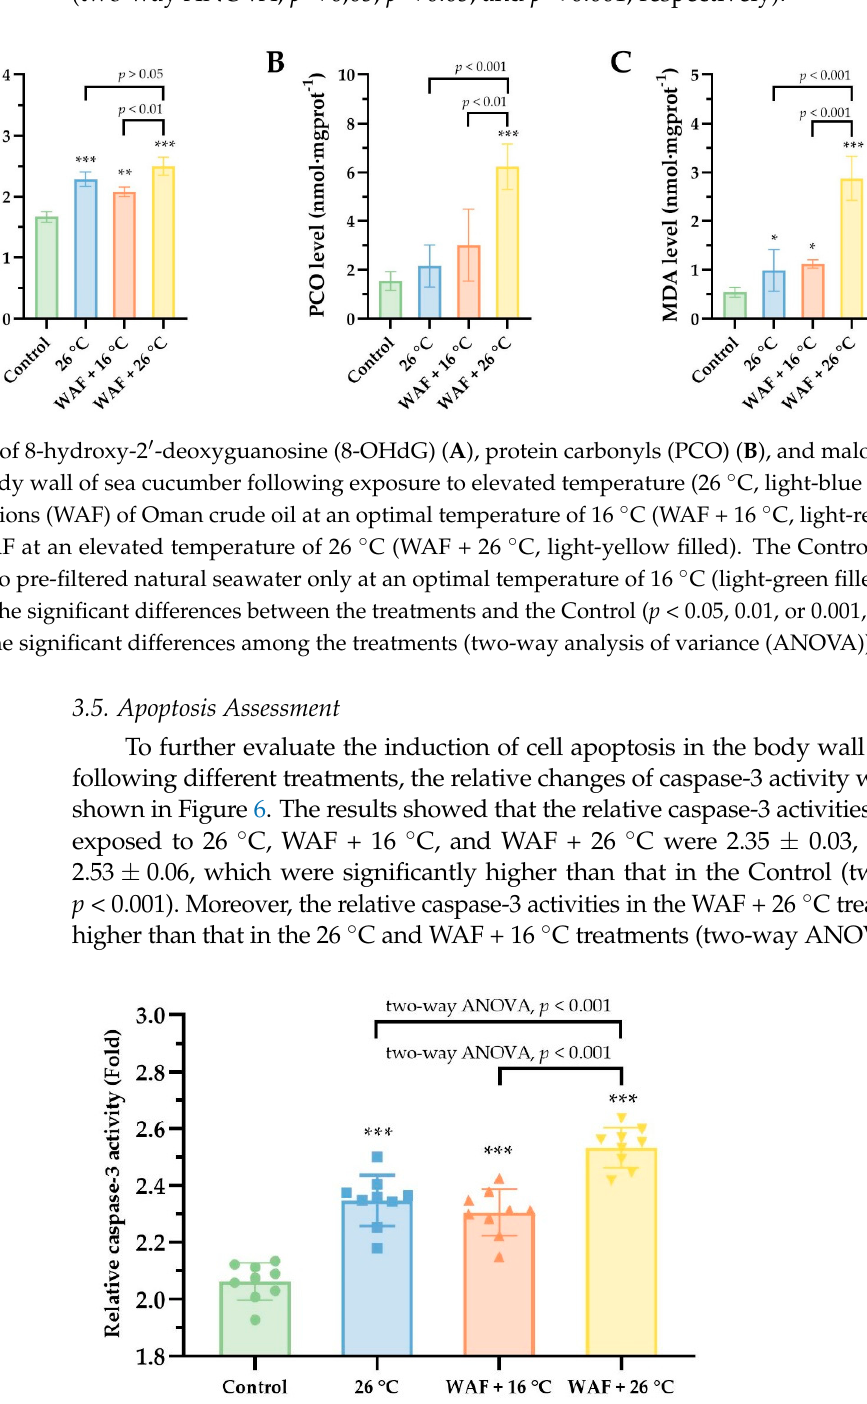
Figure 6. Relative caspase-3 activity (fold) in the body wall of sea cucumber following exposure to elevated temperature (26 ◦ C, light-blue filled square), water-accommodated fractions (WAF) of Oman crude oil at an optimal temperature of 16 ◦ C (WAF + 16 ◦ C, light-red filled up-triangle), and Oman crude oil WAF at an elevated temperature of 26 ◦ C (WAF + 26 ◦ C, light-yellow filled down-triangle). The Control was the sea cucumber exposed to pre-filtered natural seawater only at an optimal temperature of 16 ◦ C (light-green filled circle). Error bars represent 95% confidence intervals. Asterisks ***) denote the significant differences between the treatments and the Control ( p < 0.001, respectively). Dark traits denote the significant differences among the treatments (two-way analysis of variance